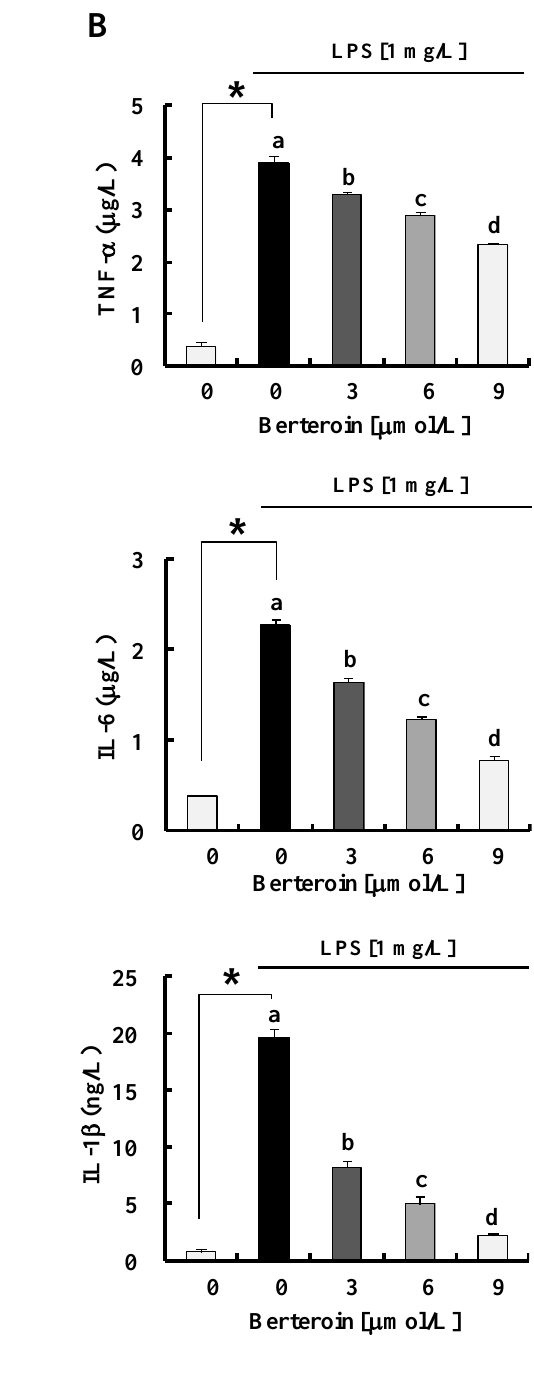
Figure 2. Berteroin decreases secretion and the transcripts of tumor necrosis factor (TNF)-α, interleukin (IL)-6, and IL-1β in lipopolysaccharide (LPS)-stimulated Raw 264.7 cells. The cells were treated with LPS and/or various concentrations of berteroin as described in Figure 1. ( A ) Total RNA was isolated and reverse-transcribed, and real-time PCR was performed. The mRNA levels of pro-inflammatory cytokines were normalized with those of GAPDH; ( B ) Conditioned media were collected after 24 h. The concentrations of TNF-α, IL-6, and IL-1β in the conditioned media were measured using the relevant ELISA kits. Each bar represents mean ± SEM ( n = 4). * Significantly different from the untreated control group (0 mg/L LPS + 0 μmol/L berteroin) ( p < 0.05). Means with different letter (a, b, c or d) are significantly different among the berteroin groups ( p <